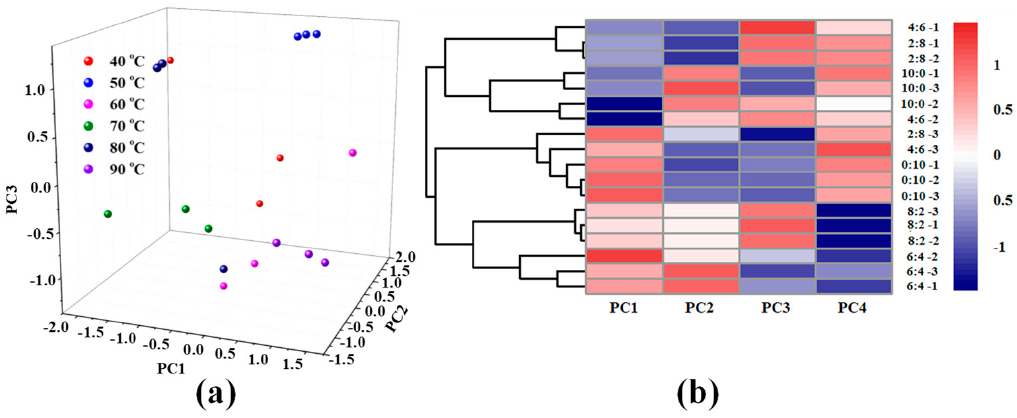
Figure 4. ( a ) Principal component analysis (PCA) and ( b ) heatmap of the SP and MP system with various MP/SP proportions at different heating temperatures.